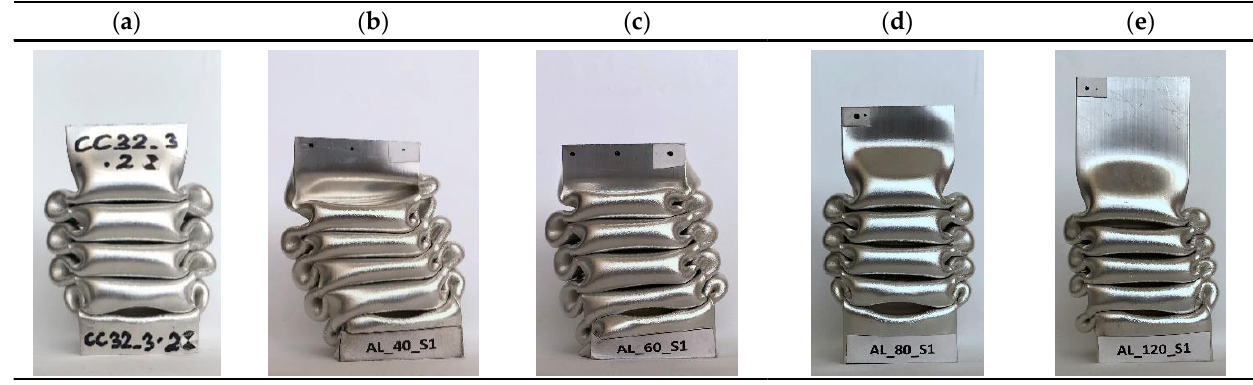
Figure 11. Comparison of experimentally tested specimens with foam length ( a ) 0 mm,( b ) 40 mm,( c ) 60 mm,( d ) 80 mm, and ( e ) 120 mm.